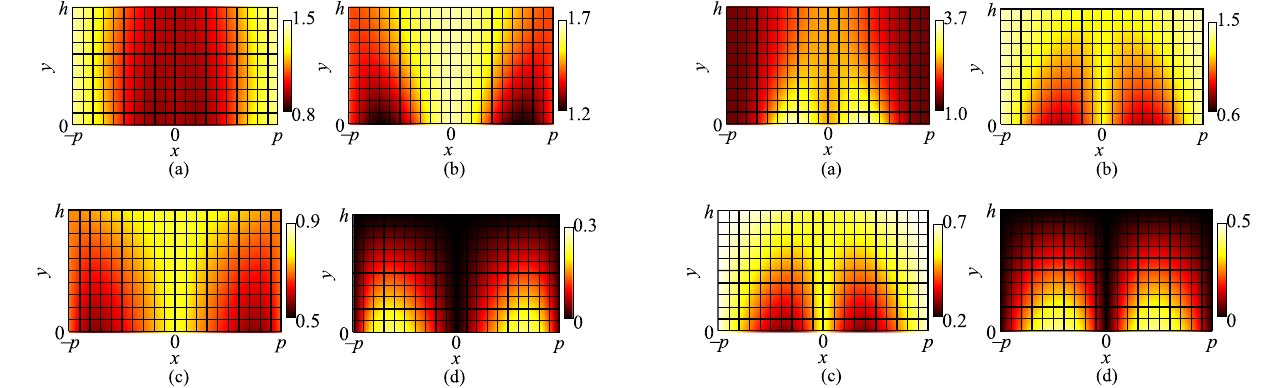
Fig. 5. Calculated characteristic impedances and electric lengths for the groove illusion of Figure 1. (a) Normalized characteristic impedance Z 0 x / h . (b) Normalized characteristic impedance Z 0 y / h . (c) Normalized electrical length b l / k D d . (d) Normalized electrical length b M l M / k D d . h and k are the wave impedance and the wave number in the original medium, respectively.